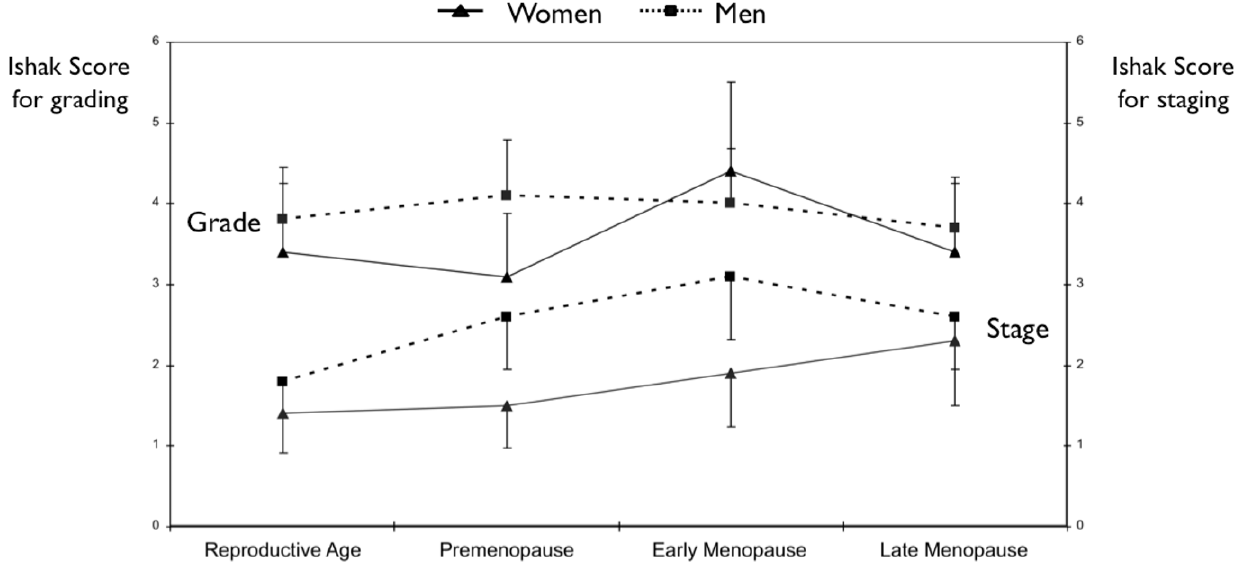
Figure 1. Mean necro-inflammation and fibrosis scores in the four subgroups of female and age-matched male patients with chronic hepatitis (Women: triangles; Men: squares). Levels of significance of the intra- and inter-group comparison are reported in the text.